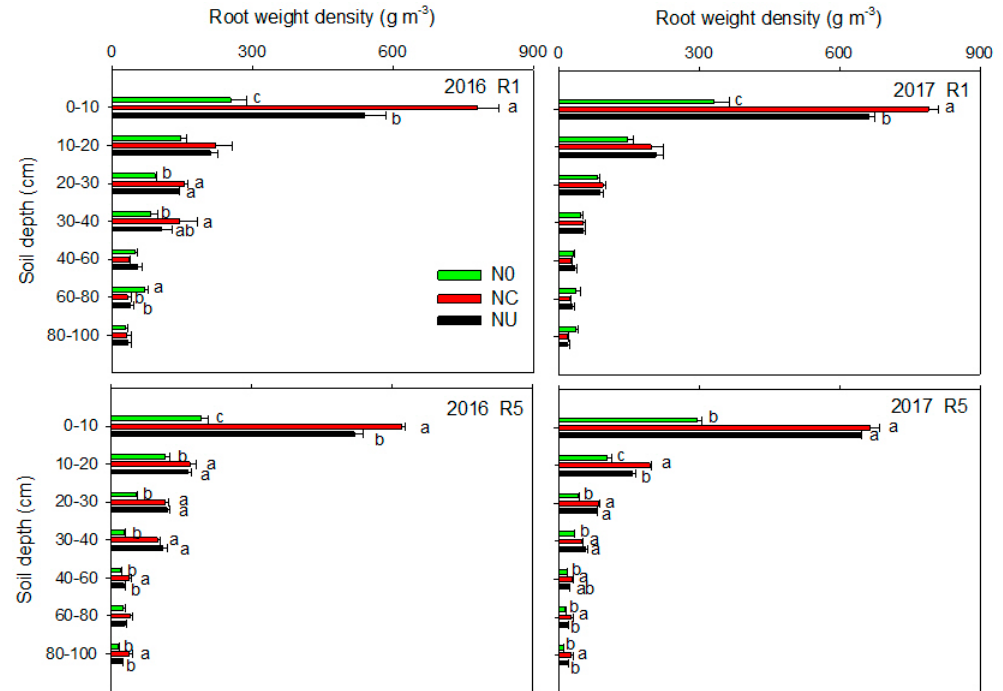
Figure 4. Root weight density in the 0–100 cm soil layers in the three treatments in 2016 and 2017 as follows: no N application (N0), combined controlled release urea and normal urea at a ratio of 1:2 (NC), and normal urea alone (NU). Letters on the graph show significant di ff erence at p < 0.05. Table 2. E ff ects of N application treatments on total root weight density (g m − 3 ) in 0–60 cm (at V6 stage) and 0–100 cm (at R1, R3, and R5 stages) soil layers during the entire growing season in 2016 and